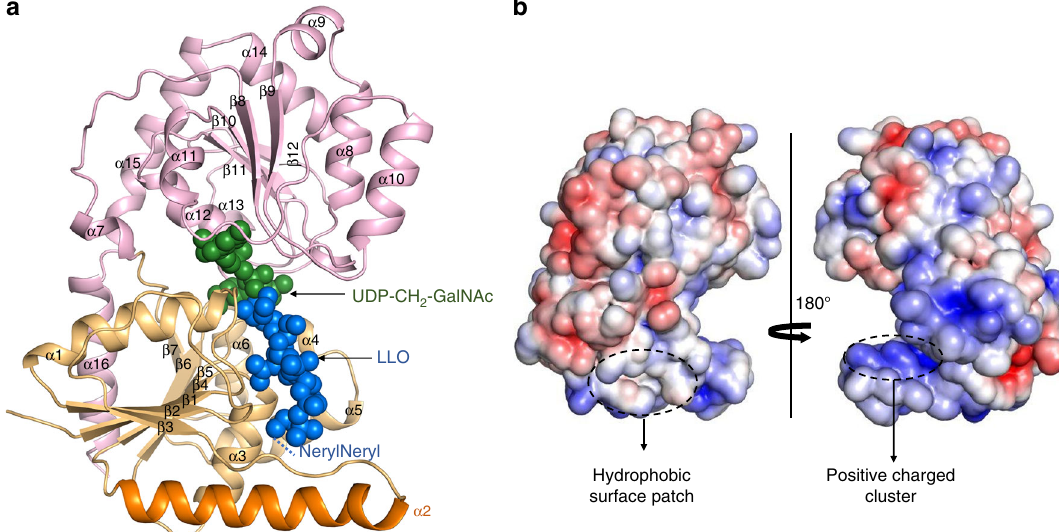
Fig. 2 Crystal structure of PglH. a Ribbon diagram of PglH in complex with synthetic LLO and UDP-CH 2 -GalNAc. N-terminal and C-terminal domains are colored in light pink and light orange, respectively. The N-terminal domain of PglH (residues 1 to 168) contains a parallel, 7-stranded β -sheet connected by six α -helices. The C-terminal domain (residues 185 to 357) contains a parallel, 5-stranded β -sheet connected by seven α -helices and a terminal α -helix that folds back to the N-terminal domain. Alpha helix α 2 (termed “ ruler helix ” ) is shown in dark orange. Bound substrates are shown as spheres (green for UDP- CH 2 -GalNAc, blue for LLO analog). b APBS-calculated electrostatic surface potential of PglH, color coded from blue (most positive) to red (most negative) to white (uncharged). The orientation of the left panel is identical to that in